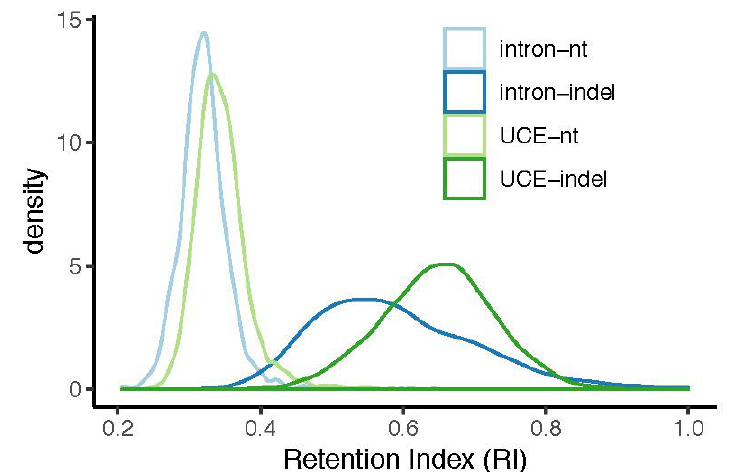
Figure 4. Frequency distribution of ensemble retention index (RI) calculated using individual gene trees by intron indel gene trees, UCE indel gene trees, intron nt gene trees, and UCE nt gene trees. Ensemble RI of individual loci should provide a more accurate measure of homoplasy than RI of species trees by minimizing the role of hemiplasy. Indel gene trees exhibit substantially higher RI than nt gene trees.